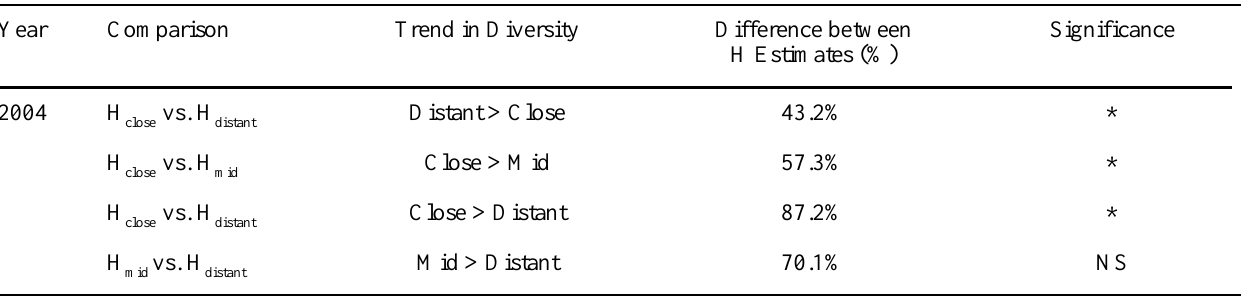
Table 2. Changes in small-mammal diversity H’ (Shannon-Wiener index) in 2004 and 2005 at different distances from the I-15 in southern Utah,